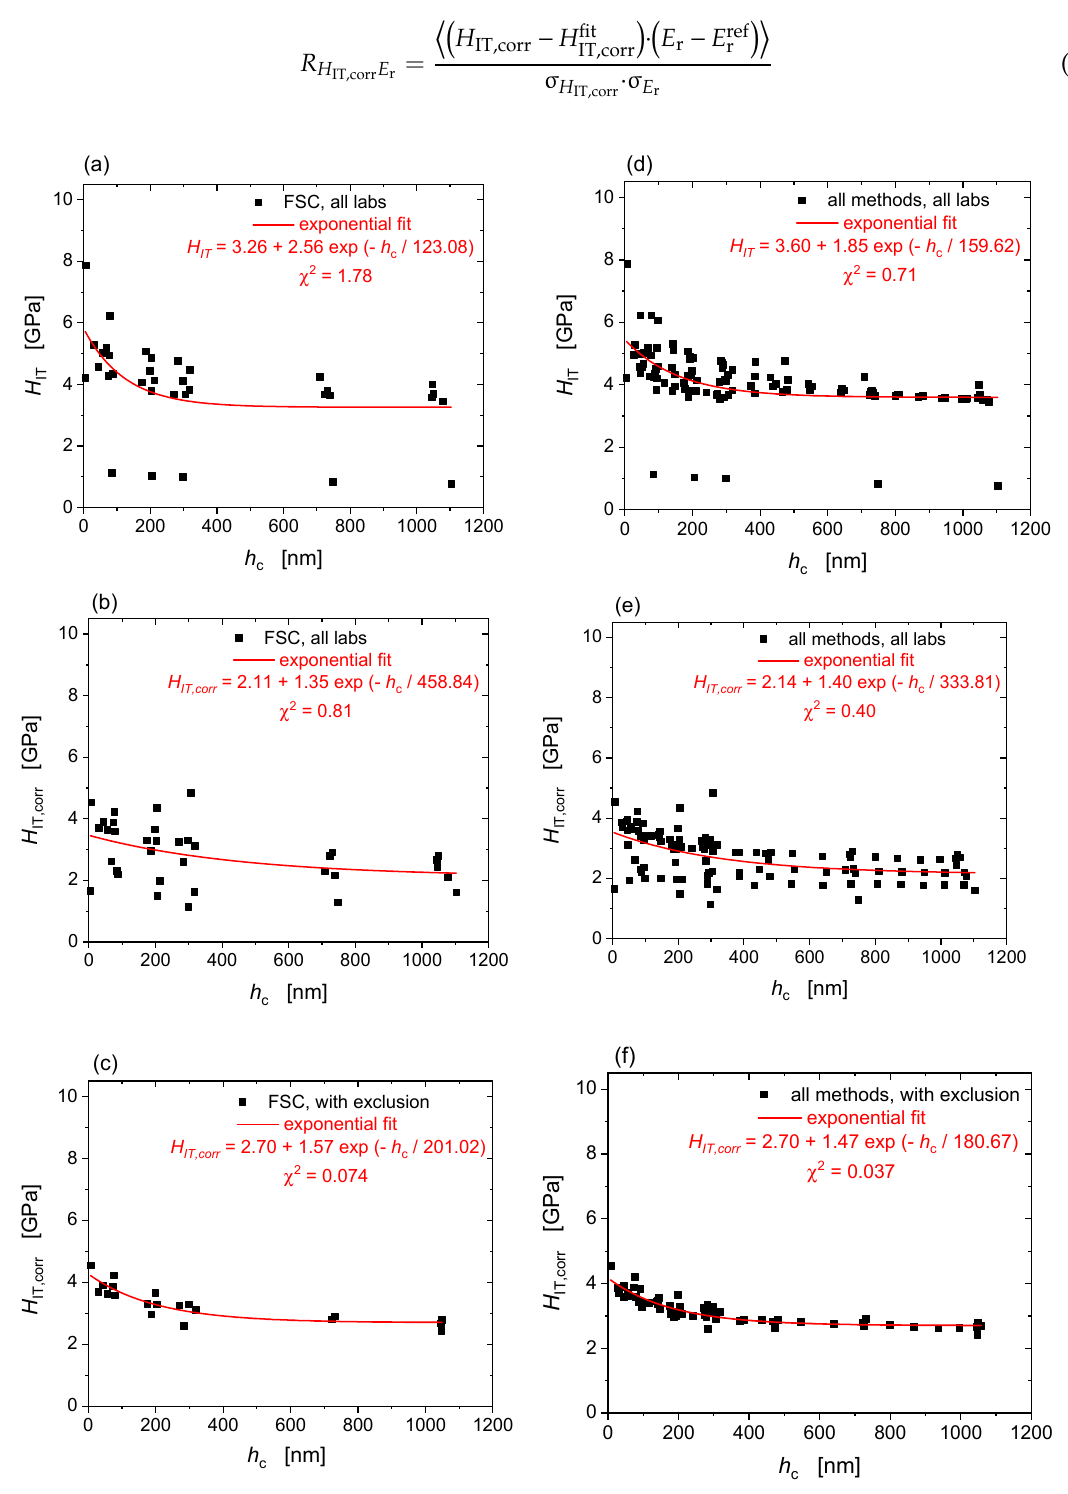
Figure 6. Exponential fits to raw hardness data, EMC corrected hardness and EMC corrected hardness with exclusions of T91 measured in FSC mode (a, b, c) and by all methods combined (d, e, f).